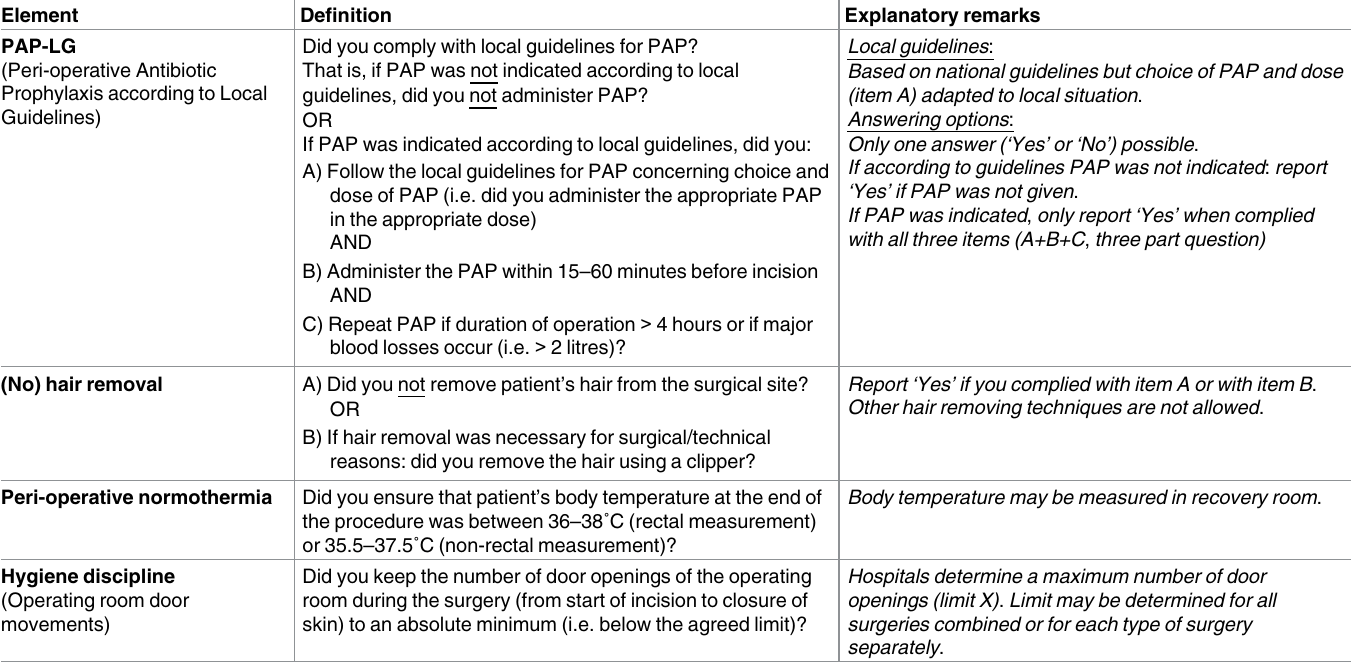
Table 1. Four elements of the